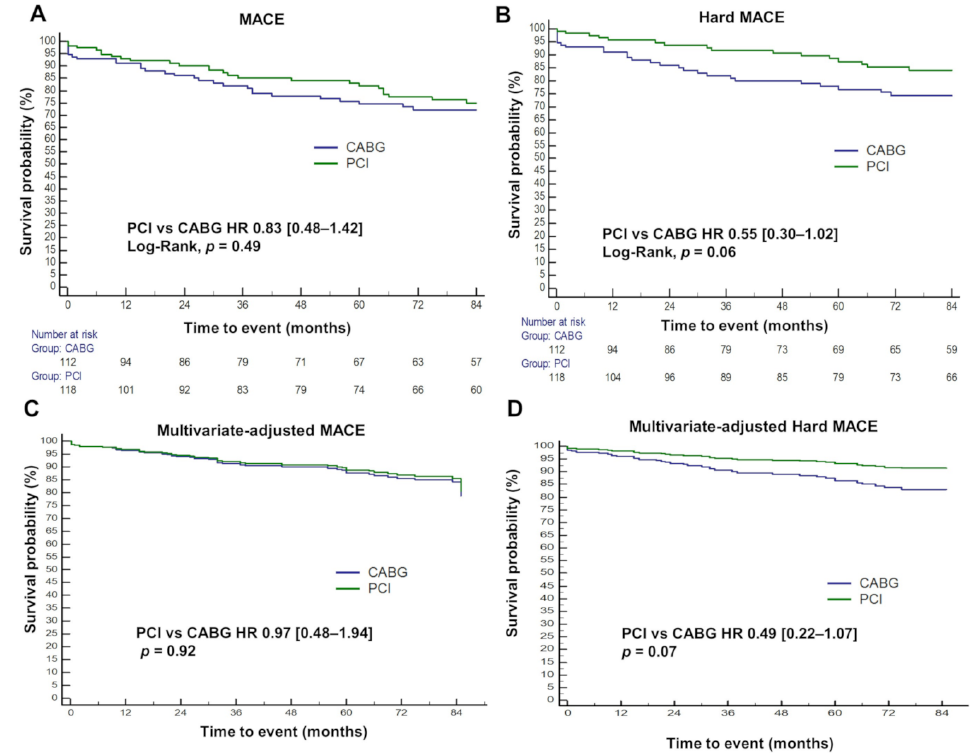
Figure 4. Unadjusted and multivariate-adjusted survival plot of composite endpoints. Kaplan- Meier plot of ( A ) major adverse cardiac events (MACE) and ( B ) hard MACE. The survival curve of multivariate-adjusted MACE and hard MACE are shown in ( C , D ), respectively. Adjusted for age ≥ 65, sex, HTN, ACS, CKD, CTO, DM, EF, EuroSCORE II, HTN, presence of high SYNTAX scores group, syntax score of LM, distal LM bifurcation, isolated LM disease. MACE, major adverse clinical events; CABG, coronary artery bypass graft; PCI, percutaneous coronary intervention; HR, hazard ratio. All other abbreviations including the adjusted variables are listed in Tables 1 and